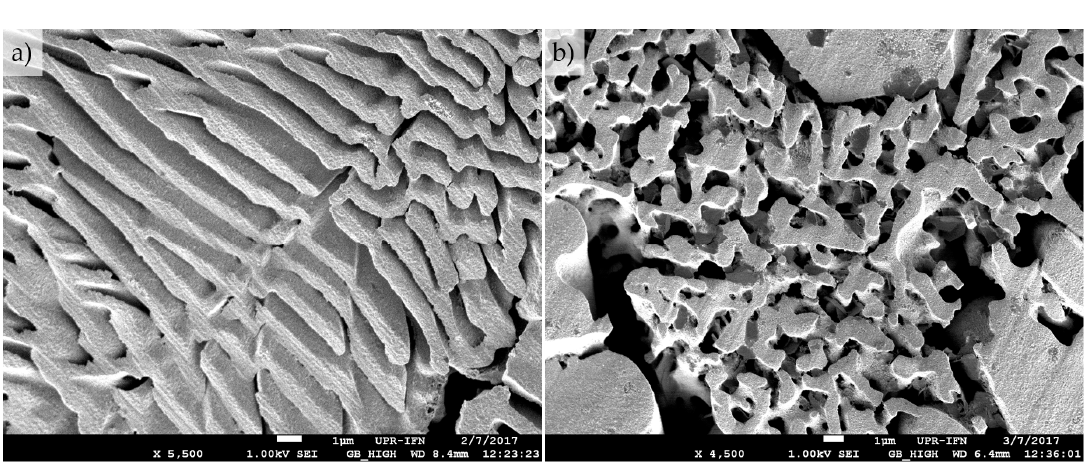
Figure 10. SEM image of: ( a ) EC and ( b ) HC-2 samples corroded to determine pore and ligament size.